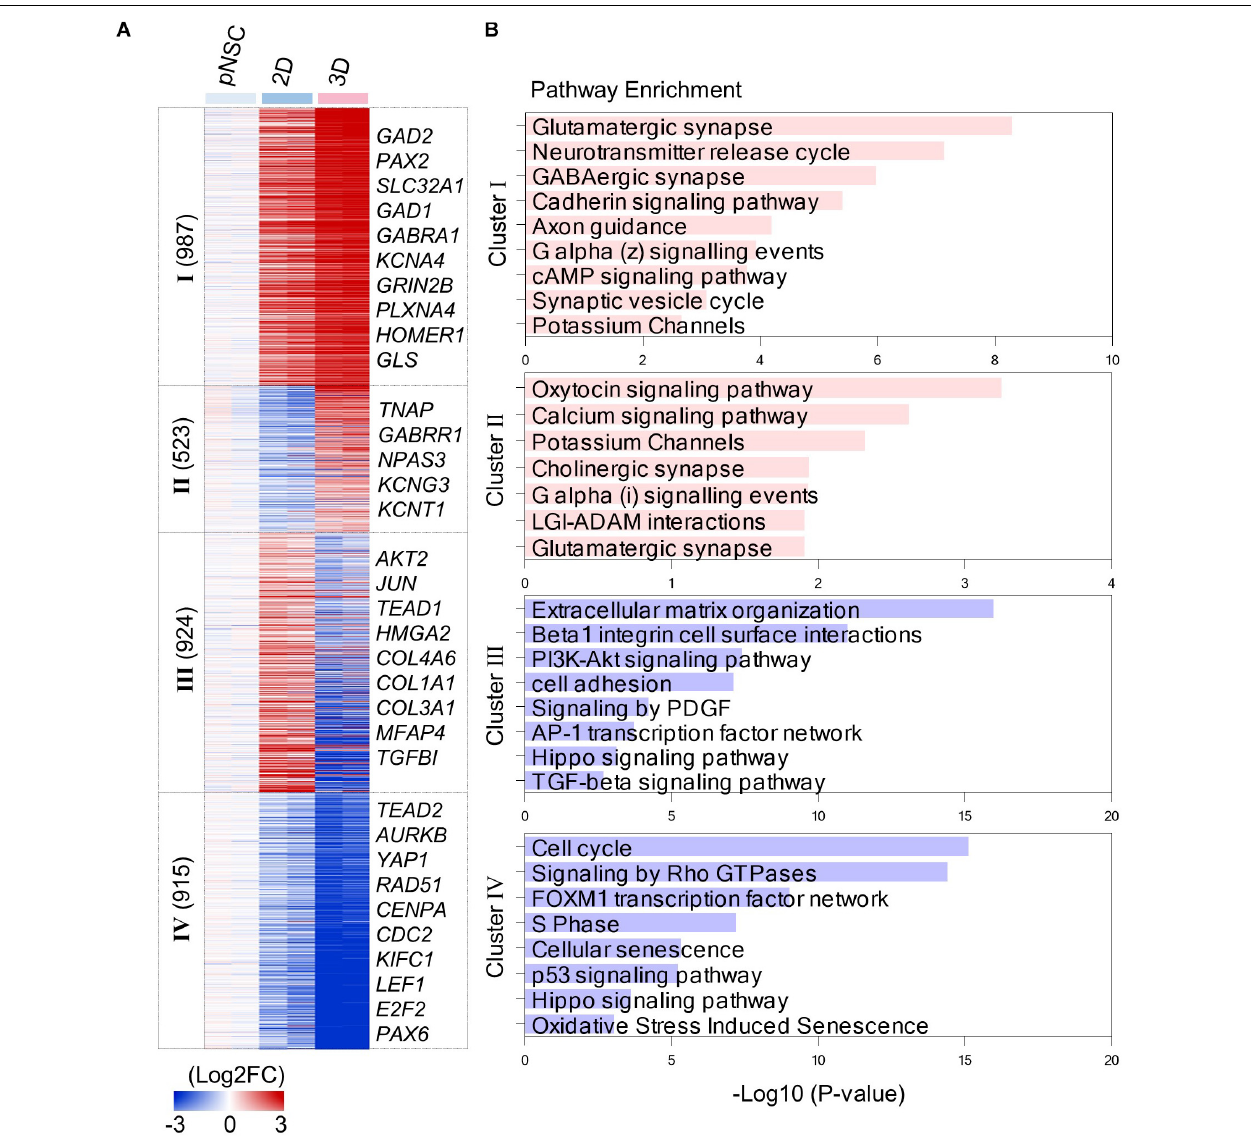
FIGURE 4 | Transcriptomic analysis of simBOs and 2D differentiation. (A) Heat map of differentially expressed genes between 2D and 3D differentiation. Expression value was normalized to those of iPSCs. Cluster name and gene number in each cluster were indicated in left panel and representative gene names in each cluster were indicated in the right panel. Color scale of expression value were presented in lower panel. (B) Bar chart for the –Log10( p .value) of representative enriched pathway calculated by reactome pathway enrichment